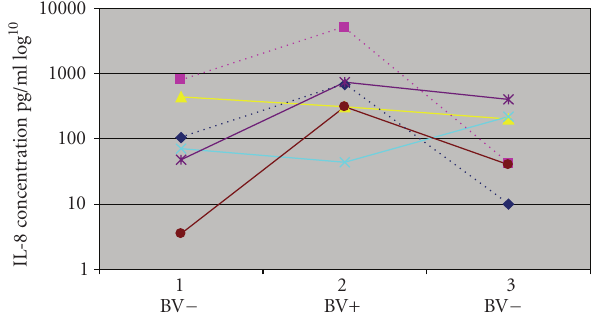
Figure 2: Genital tract IL-8 concentrations in pg/ml (log 10 ) were evaluated at three consecutive visits for 2 high-risk HIV uninfected (dotted lines) and 4 HIV infected women (solid lines) At baseline, visit 1, none of these women had bacterial vaginosis. Women were only included if data for all 3 visits was